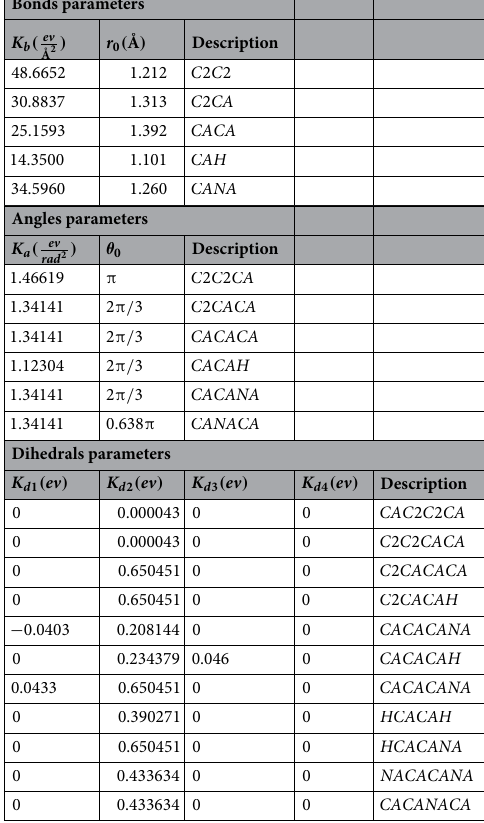
Table 1. Parameters used in simulation of the nanocar and